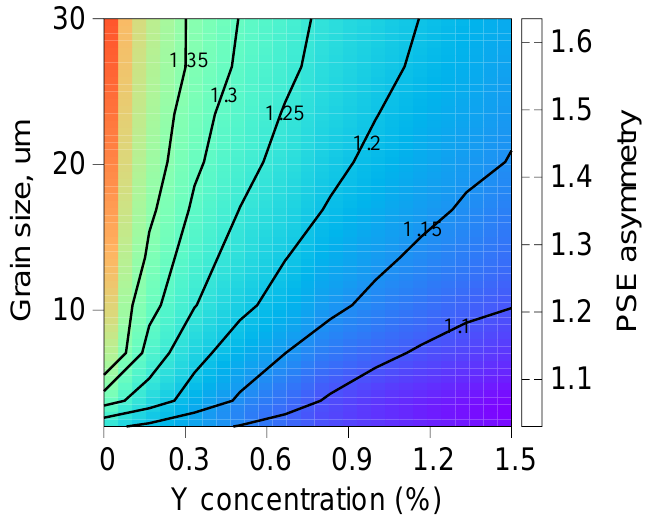
Figure 6. Model calculated asymmetry in the product of strength and elongation (PSE) between tension and compression as a function of grain size and Y content. Here, the deformation is imposed along the rolling direction (RD), and PSE is calculated until 10% strain.